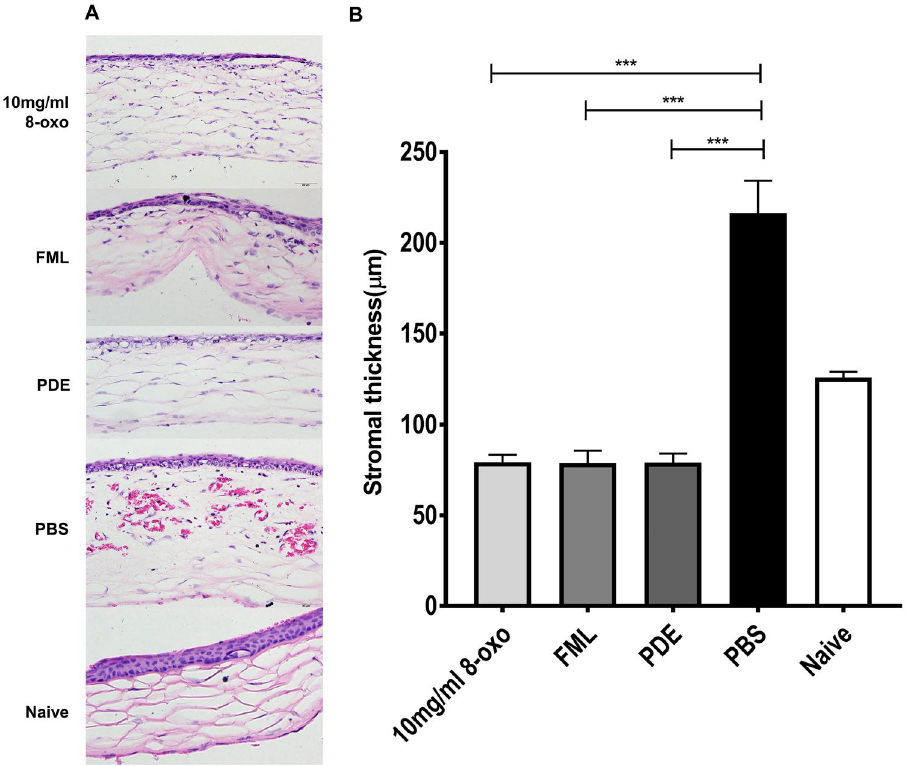
Figure 3. Histological analysis using Image J software [version 1.44; National Institutes of Health (NIH), Bethesda, MD, USA] of the cornea 1 week after treatment of ocular alkali burn model with topical 8-oxo- 2 ′ -deoxyguanosine (8-oxo-dG) or corticosteroid. ( A ) Representative images of hematoxylin and eosin (H&E) staining of the central cornea. ( B ) Comparison of stromal thickness of the central cornea. Original magnification, × 400; data are means ± standard error of the mean (SEM). *** p < 0.001. 8-oxo: 8-oxo-dG. FML fluorometholone 0.1% (1 mg/mL), PDE prednisolone acetate 1% (10 mg/mL), PBS phosphate-buffered